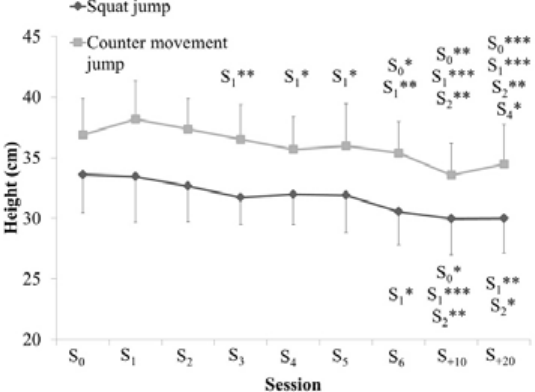
Figure 3. Squat and countermovement jump height recorded after each badminton session. Values are mean and standard deviation. A significant difference at the post hoc test with S 0 is indicated by *: P < 0.05; **: P < 0.01; ***: P < 0.001. FG strength did not change ( F 8, 88 = 1.006; P = 0.439) whereas HG strength showed a decrease (-15%, F 8, 88 = 3.337; P = 0.002; η p = 0.233) (figure 4), especially after 60 minutes of the game. There was a strong correlation between FG and HG strength ( r = 0.877; P < 0.001). The CPE increases ( F 8, 88 = 30.480; P < 0.001; η p = 0.813) and PPE ( F 8, 88 = 17.367; P < 0.001; η p = 0.713) during the entire match (figure 5).